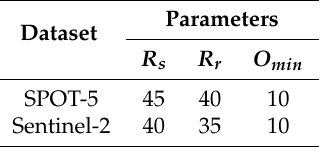
Table 3. Preliminary segmentation